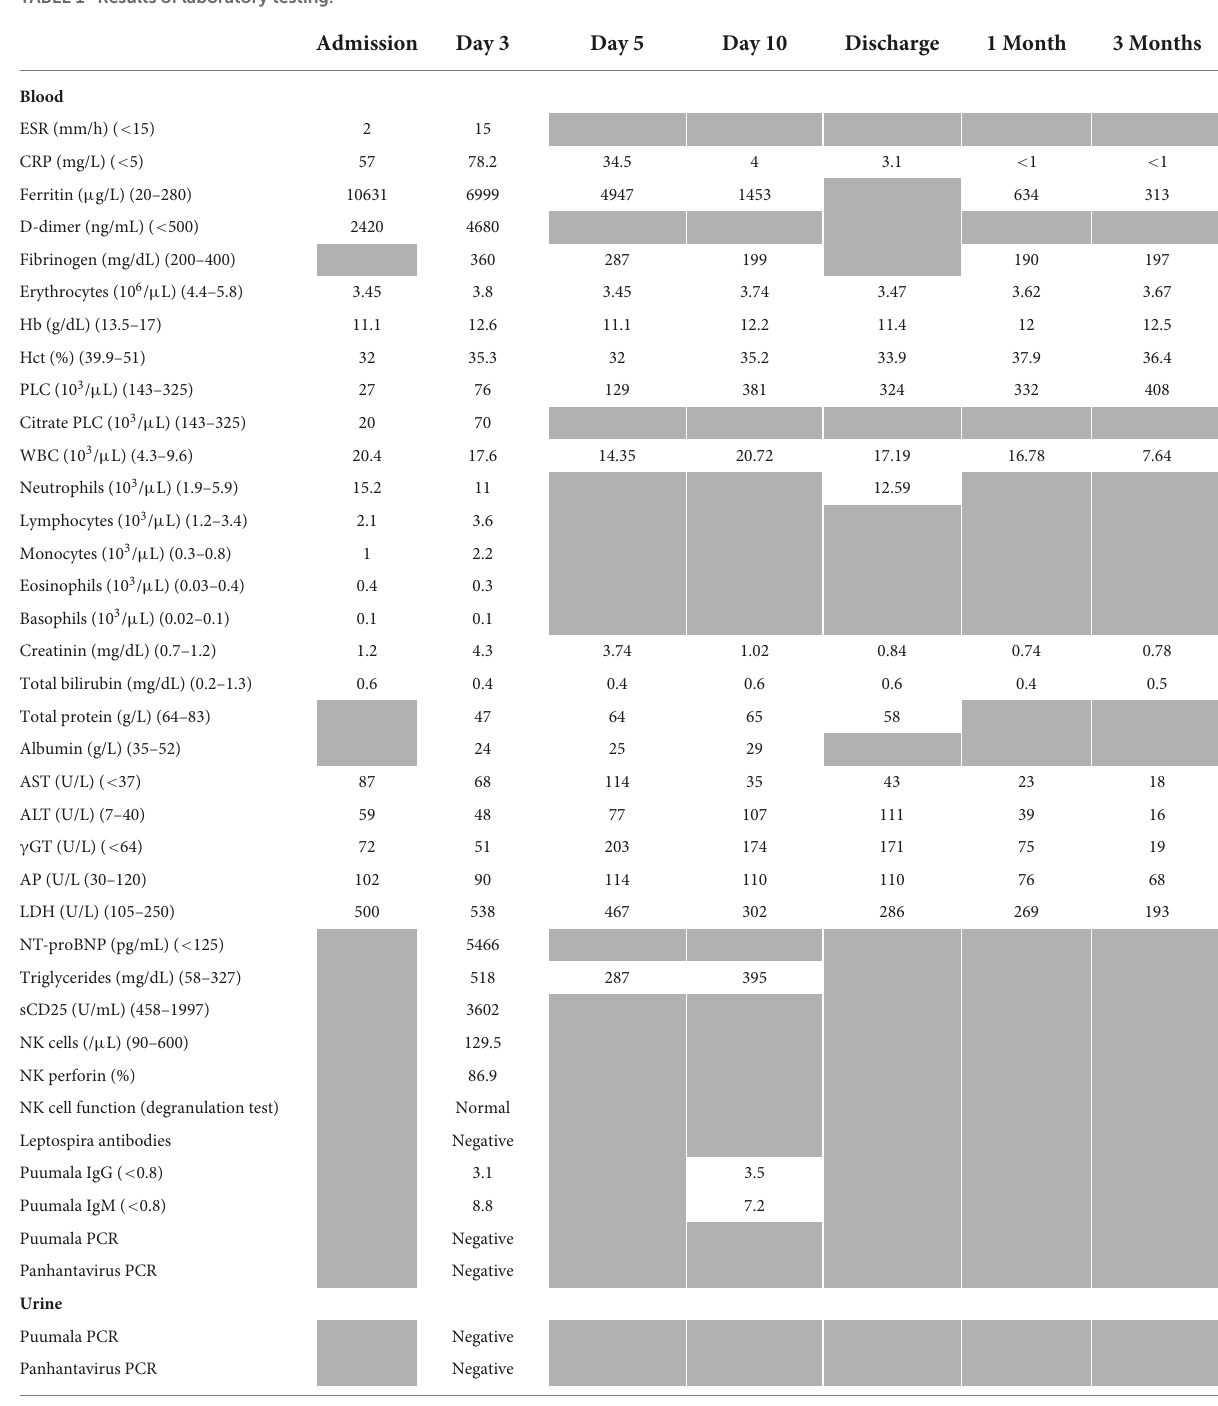
TABLE 1 Results of laboratory